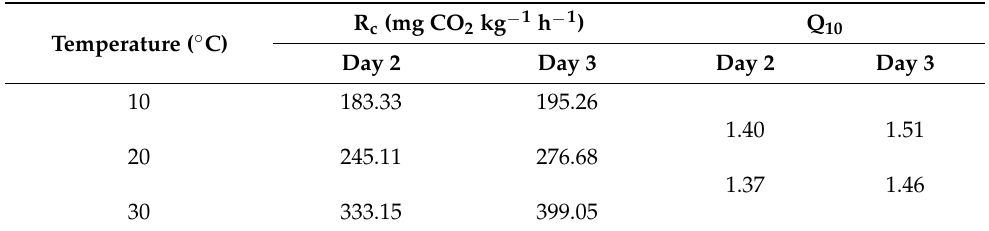
Table 1. Okra respiration rate in a closed system after three storage conditions at (10, 20 and 30 ◦ C) for 2 and 3